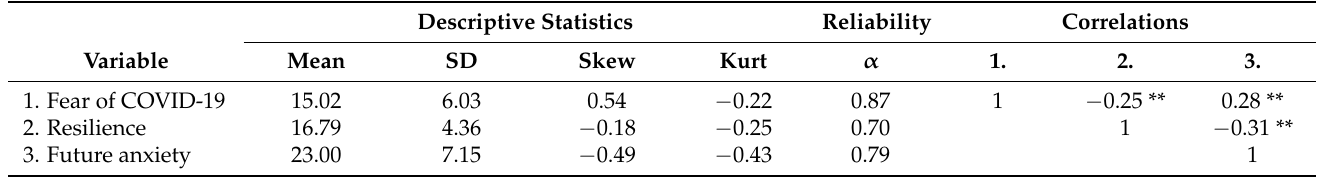
Table 2. Descriptive statistics, reliability, and correlations ( n =